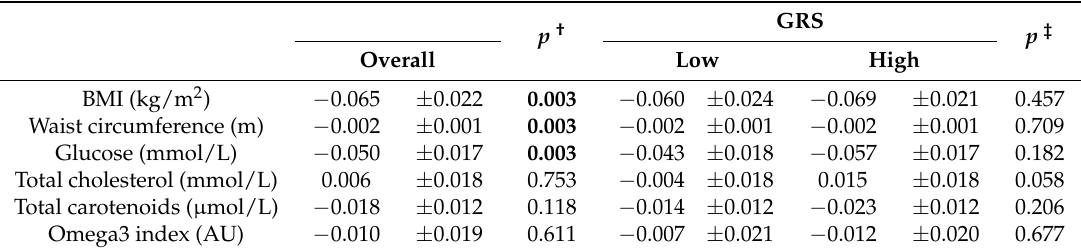
Table 3. Overall effect of MDS variation on anthropometrical and biochemical traits of the Food4Me volunteers during the intervention, and based on GRS